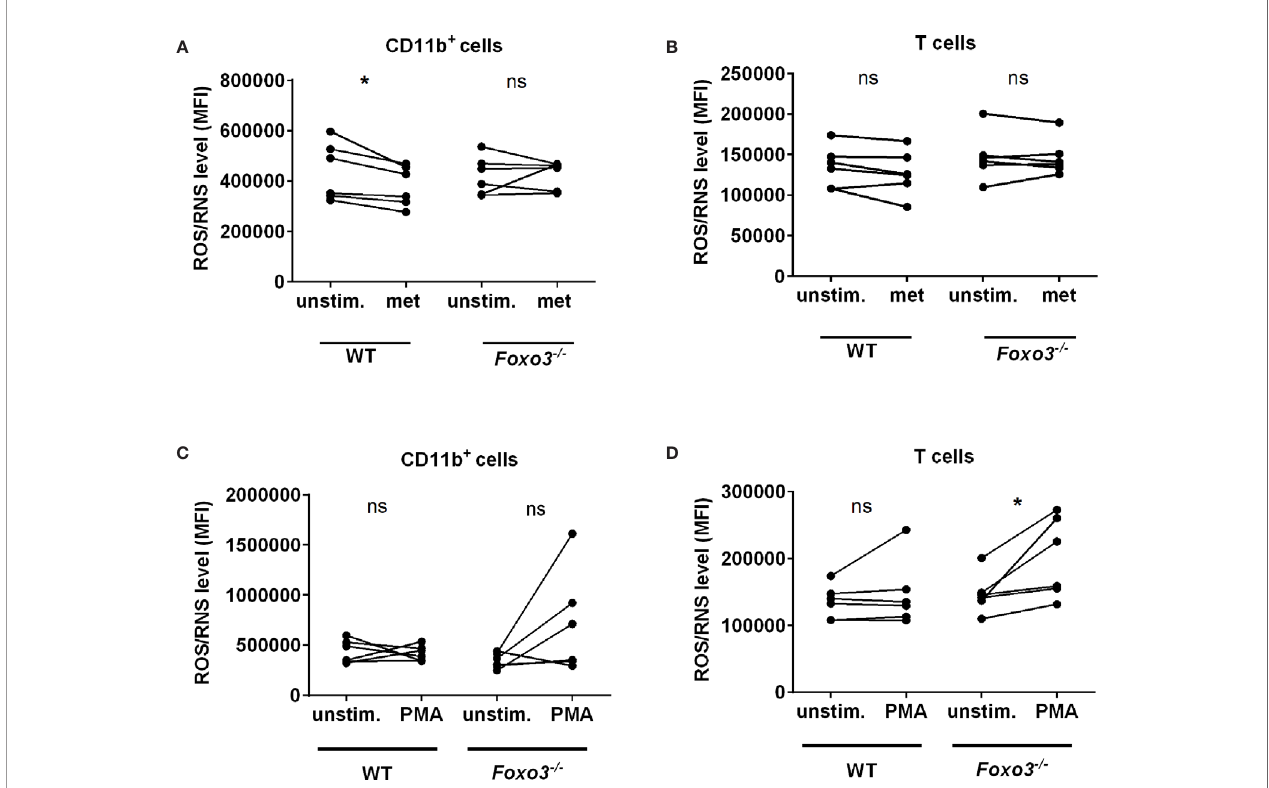
FIGURE 4 | ROS/RNS production is reduced by metformin in WT and induced by PMA in Foxo3 -/- mice. ROS/RNS level was analysed in WT vs. Foxo3 -/- splenocytes after 3 h of metformin [0.1 mM] (A, B) or 10 min of PMA [100 ng/ml] treatment (C, D) . Mouse splenocytes were labeled with DCFH-DA and ROS/RNS level was analysed by FC (n=6) in (A, C) CD11b + myeloid cells and (B, D) CD3 + T cells. Signi fi cance was evaluated using the Wilcoxon test. *P ≤ 0.05; ns, not signi fi